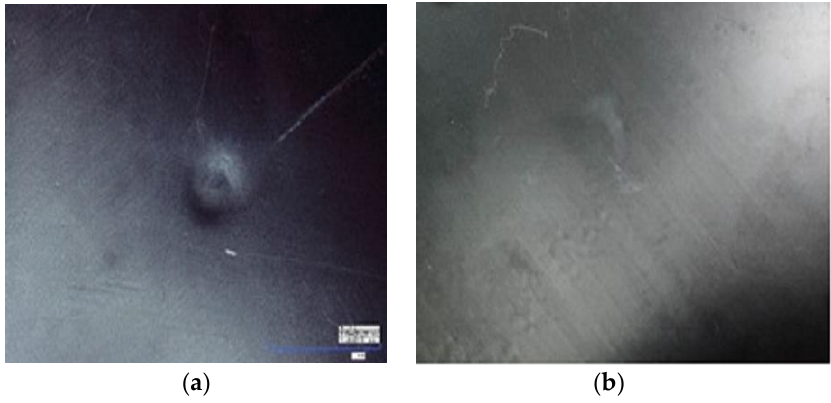
Figure 5. Indentation rebound: depth vs. time graph. Figure 6 shows a 40 J impacted specimen from the impacted side and the back side. The back side surface of the specimen remains undamaged.